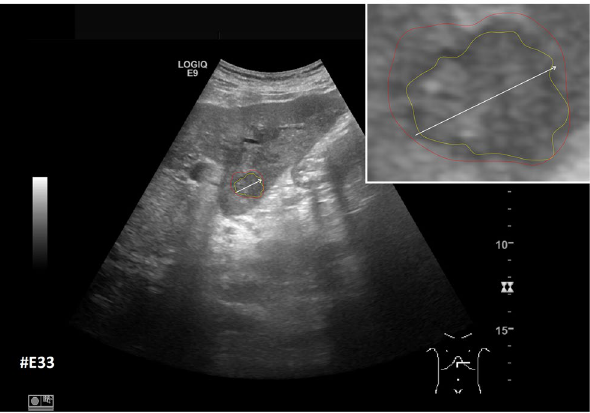
Figure 13. Example of a segmentation with a DSC of less than 80%. Depicted is the native image with a zoomed view of the metastasis (white box). The red outline represent the manual segmentation including the white arrow representing the manually drawn maximum diameter. The yellow outline represents the result of the semi-automatic